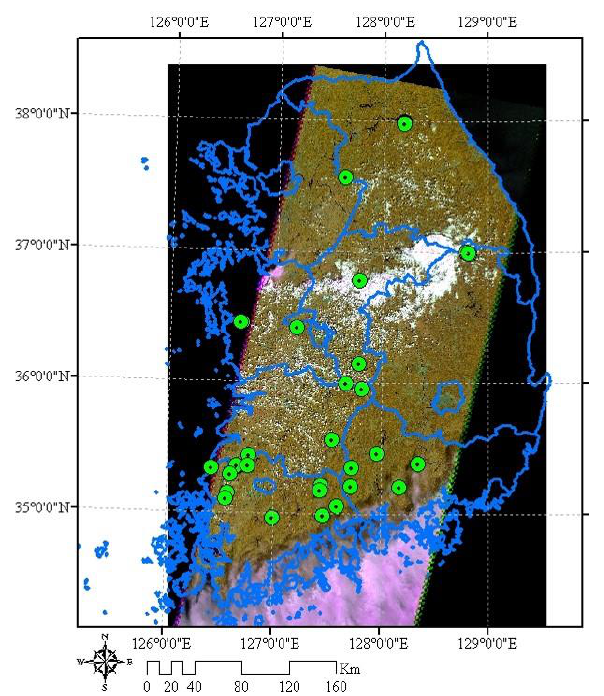
Figure 1. Landsat-5 TM image (RGB 453) of the study area acquired on Sep. 9 th 2007 and sampling plot in South Korea.